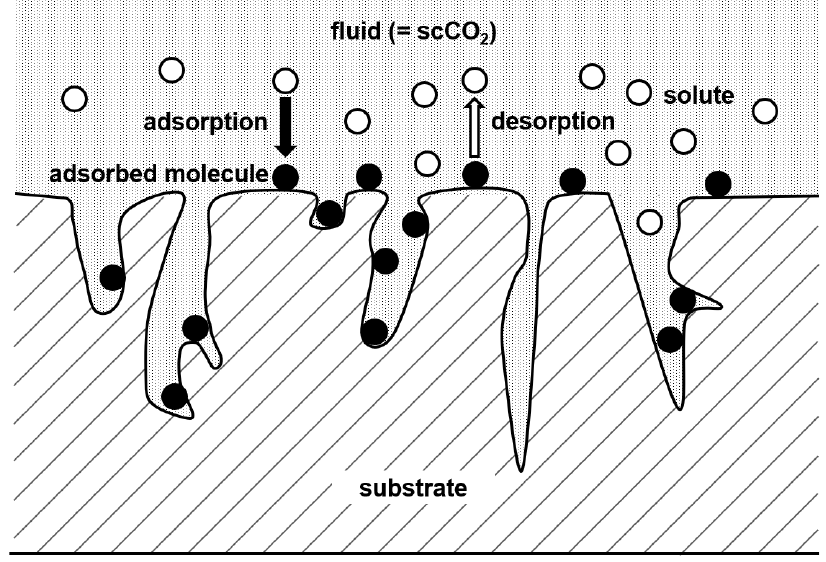
Figure 2. Adsorption at the surface of a substrate.